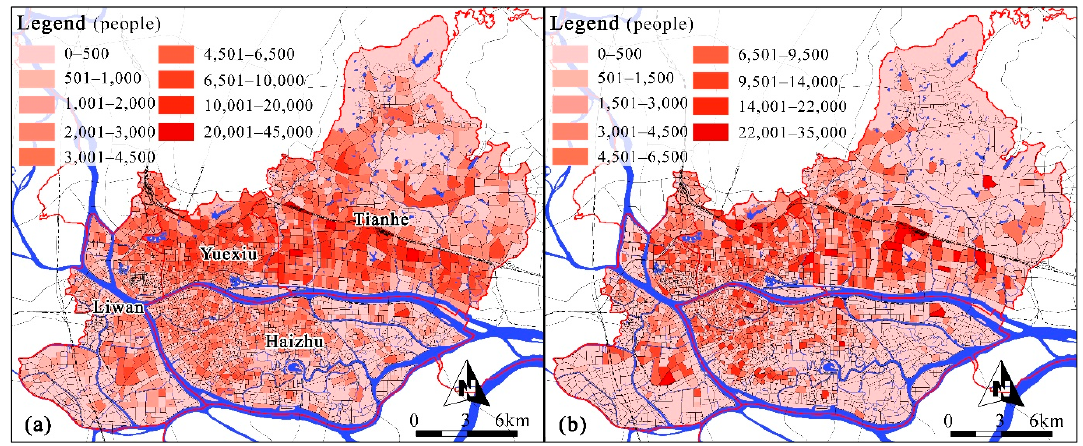
Figure 4. Population distribution and size during the ( a ) day and ( b ) night.